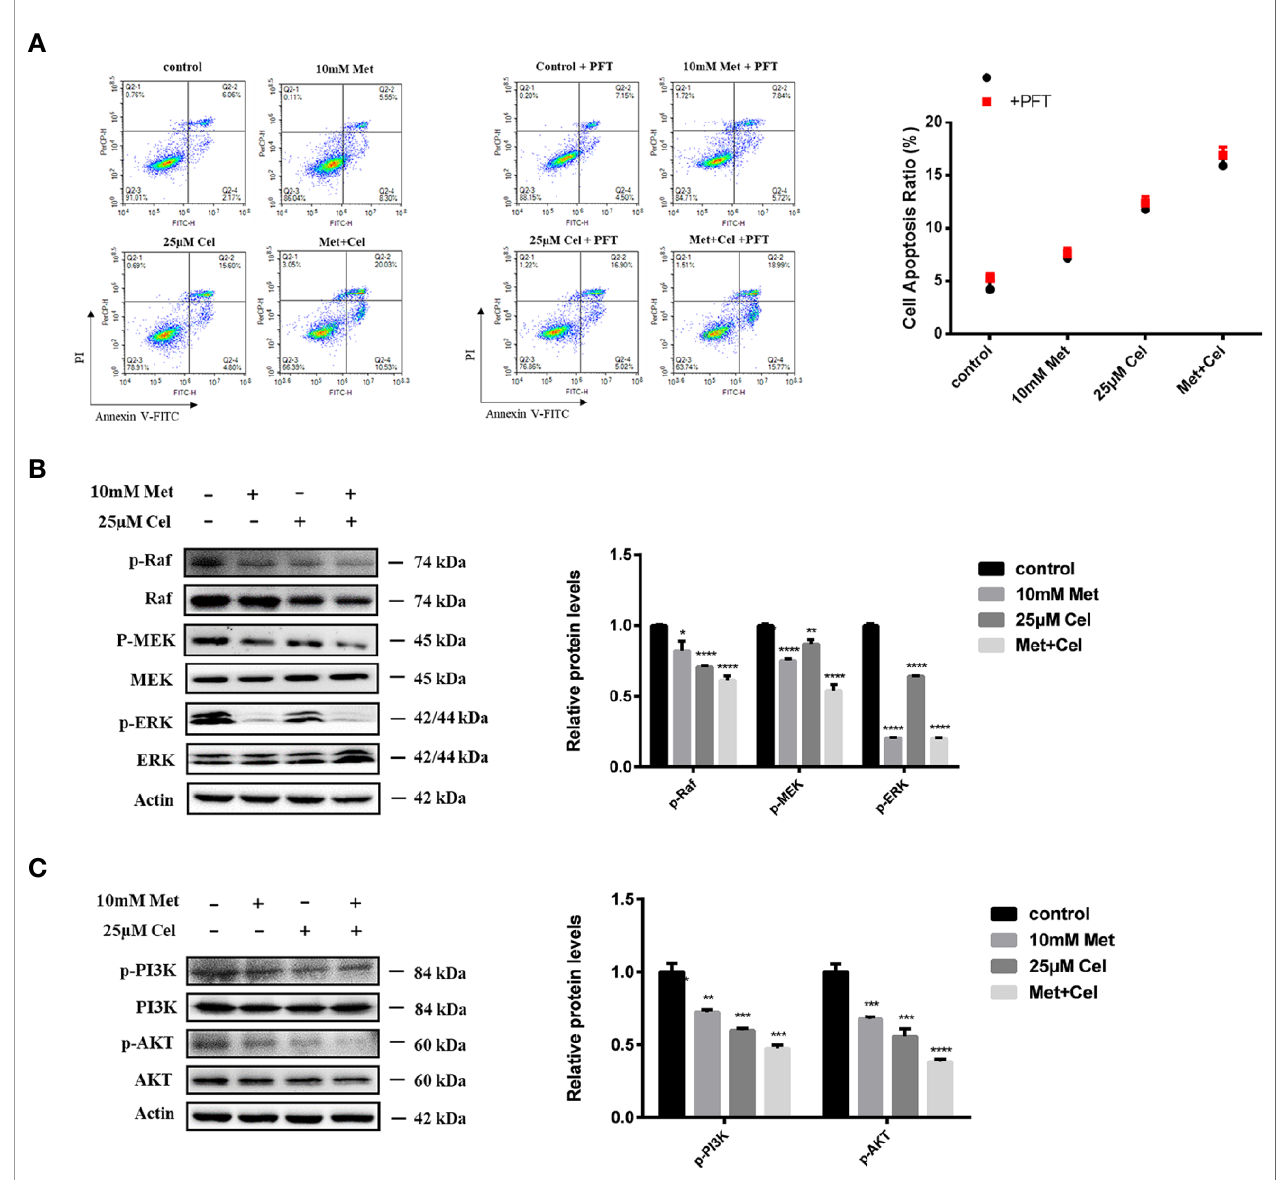
FIGURE 6 | Combined treatment with metformin and celecoxib may induce apoptosis by inhibiting ERK and PI3K/AKT signaling pathways. (A) Cell apoptosis analysis of A549 cells treated with 10 mM metformin and/or 25 m M celecoxib for 48 h in the absence or presence of 5 m M PFT. Quanti fi cation of the proportion of the apoptotic cells was shown in the right panel. (B) Western blot analysis was used to detect the phosphorylation state of Raf, MEK, ERK after treatment with 10 mM metformin and/or 25 m M celecoxib for 48 h. Band intensity was quanti fi ed by Image J software. (C) Western blot analysis was used to detect the phosphorylation state of PI3K and AKT after treatment with 10 mM metformin and/or 25 m M celecoxib for 48 h. Band intensity was quanti fi ed by Image J software. Data are represented as mean ± SD. * p < 0.05, ** p < 0.01, *** p < 0.001, **** p <